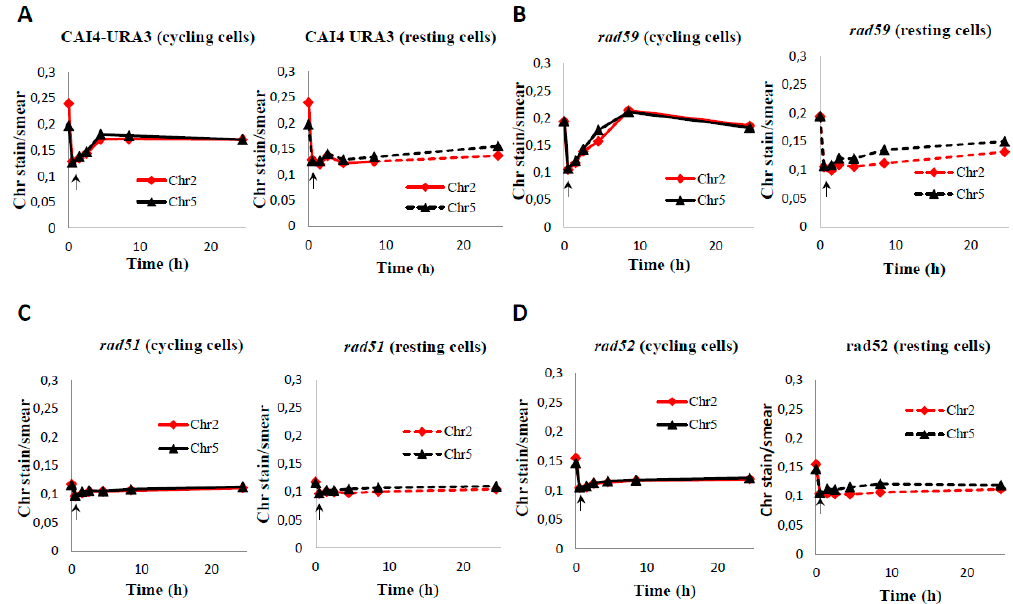
Figure 6. Quantification of Chr2 and Chr5 intensities during the MMS-treatment and the post-MMS incubation of wild type CAI4-URA3 ( A ) and HR Uri+ mutants Ca rad59 ( B ), Ca rad51 ( C ) and Ca rad52 ( D ). Post-MMS incubation was carried out in YPD (cycling cells) or PBS (resting cells). PFGE gels shown in Figure 5 were quantified as described in Materials and Methods. Initial time (0) corresponds to samples before MMS treatment. Arrows within each panel shows the MMS-treated sample.